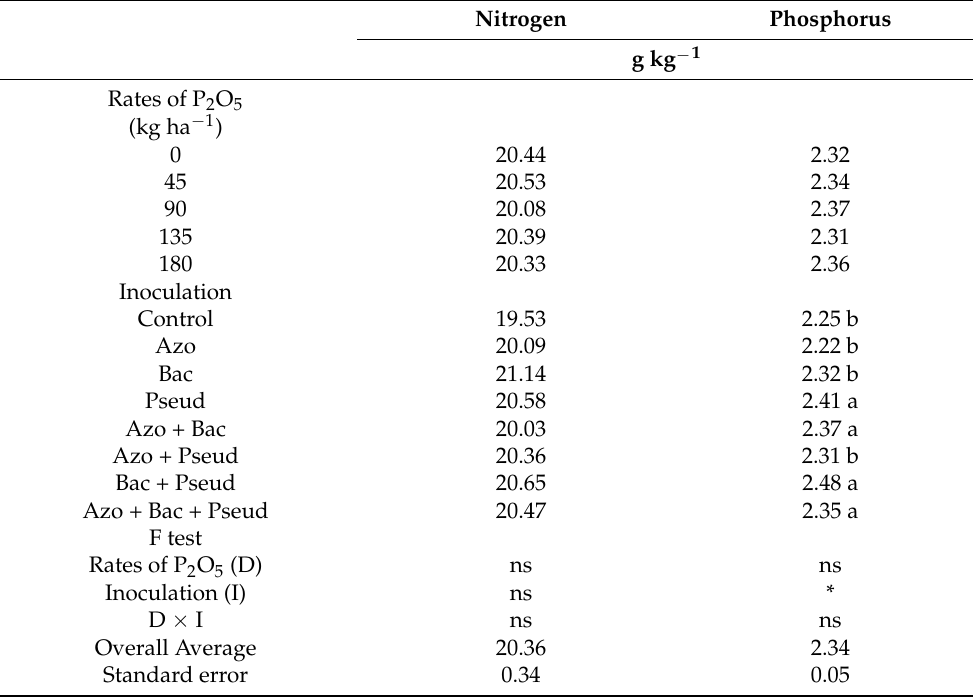
Table 2. Nitrogen and phosphorus concentrations in sugarcane diagnose